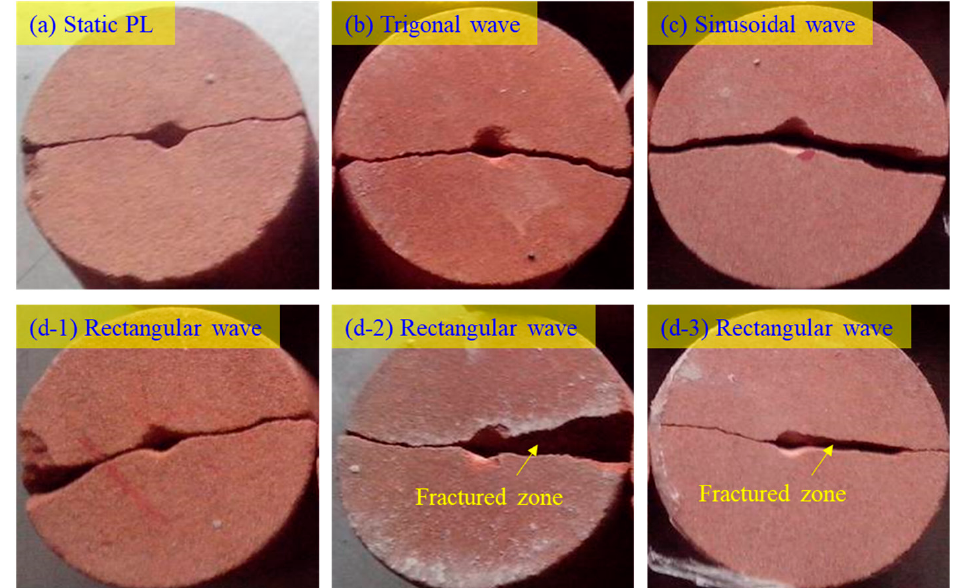
Figure 8. Failure patterns of the YNS sample subjected to ( a ) static point loading and ( b – d ) CPLs with di ff erent waveforms.